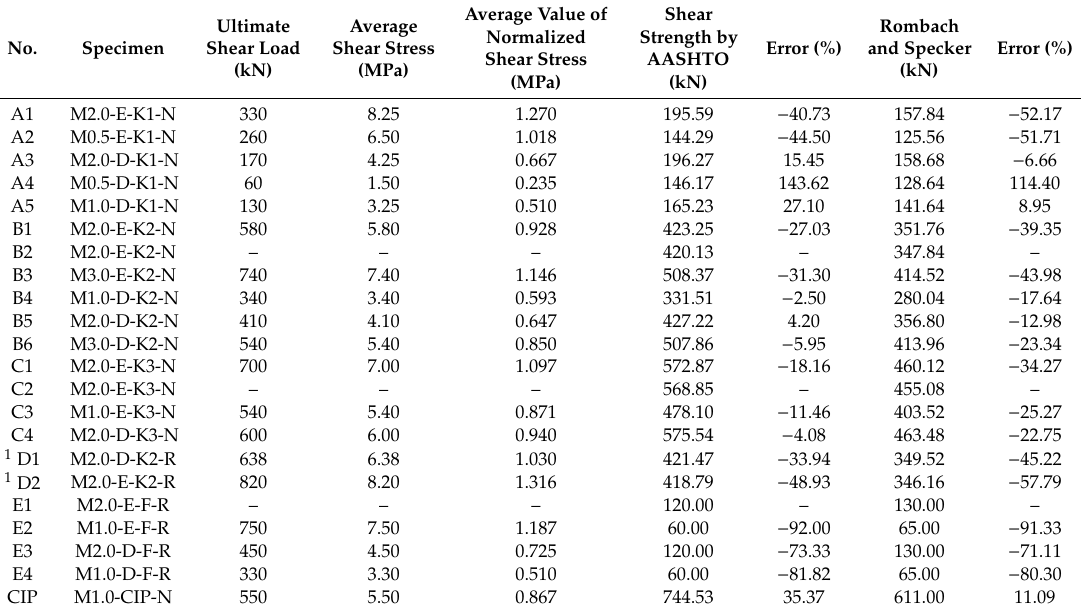
Table 2. Experimental results of the joints tested under monotonic